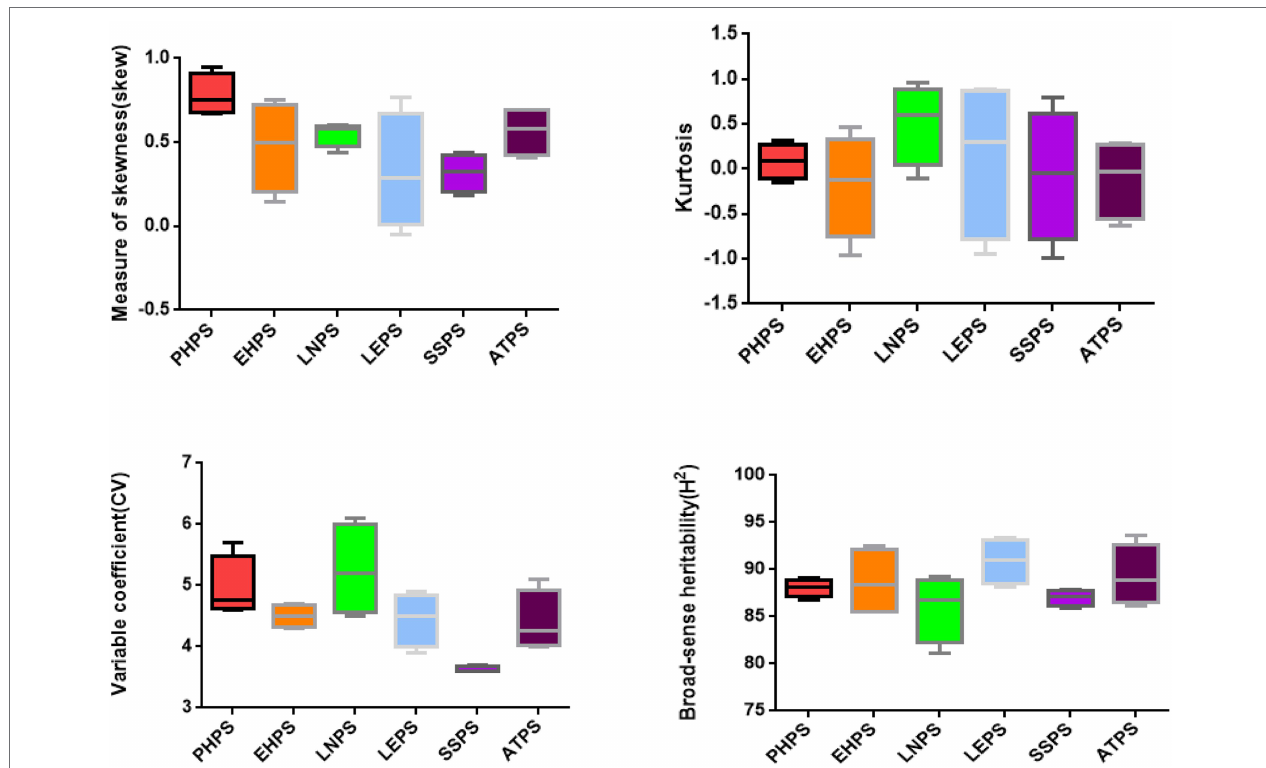
FIGURE 4 | Descriptive statistics and broad-sense heritability for PHPS, EHPS, LNPS, LEPS, SSPS, and ATPS (boxplot).